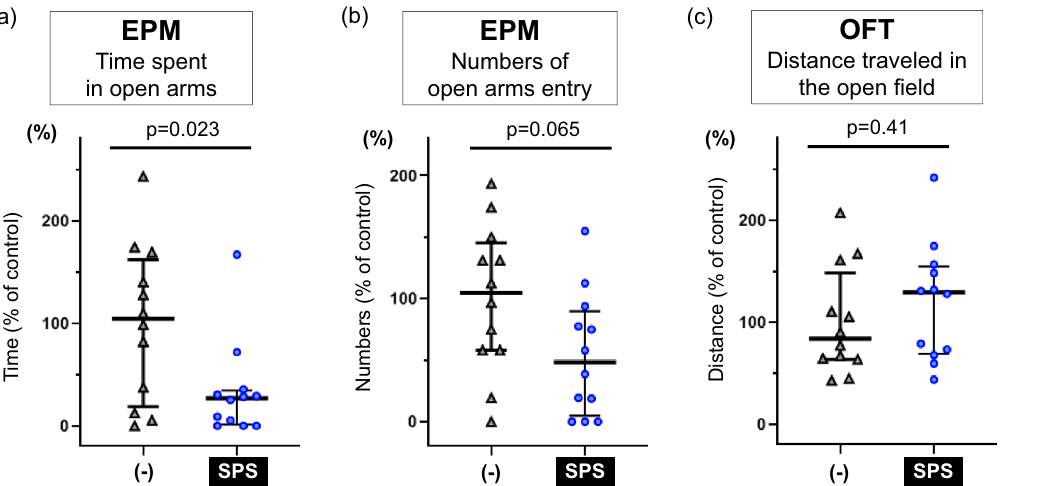
Figure 2. SPS induces anxiety-like behavior in the EPM. ( a ) Time spent in the open arms of the EPM is shown. Exposure to SPS significantly reduced time spent in the open arms (median [IQR]; non SPS: 104.2 [31.1–147.5],